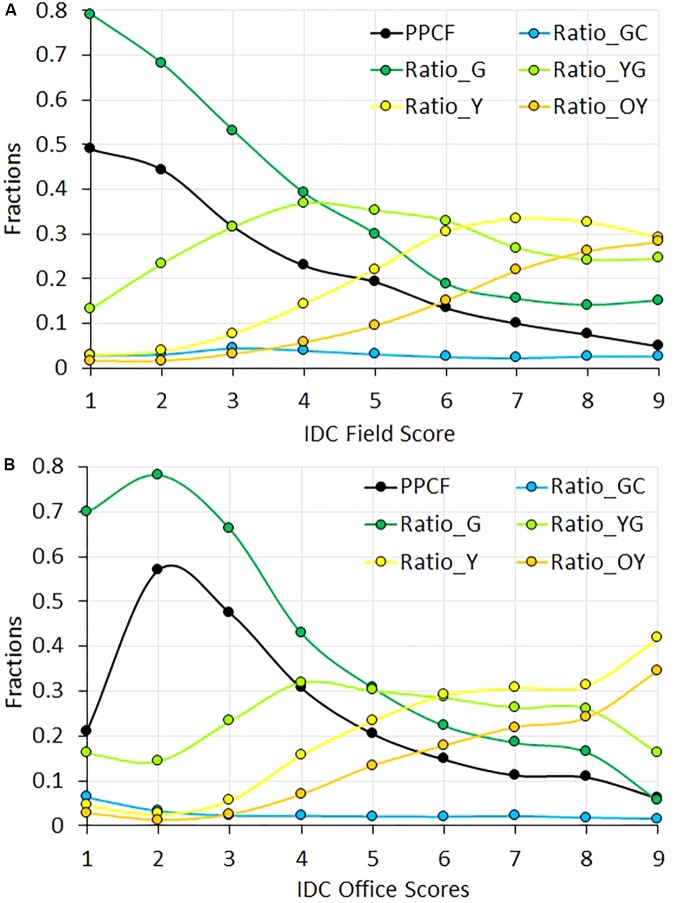
The trend of the six color parameters as a function of iron deficiency chlorosis (IDC) field score (A) and office score (B). The color parameters were resulted from the processing of RGB images of soybean field plots.